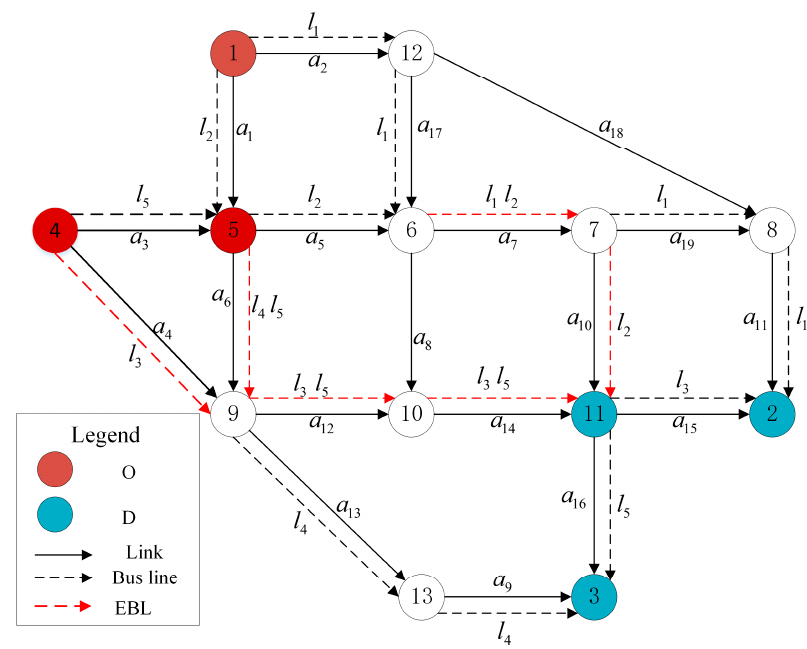
Figure 8. EBLs allocation schemes.